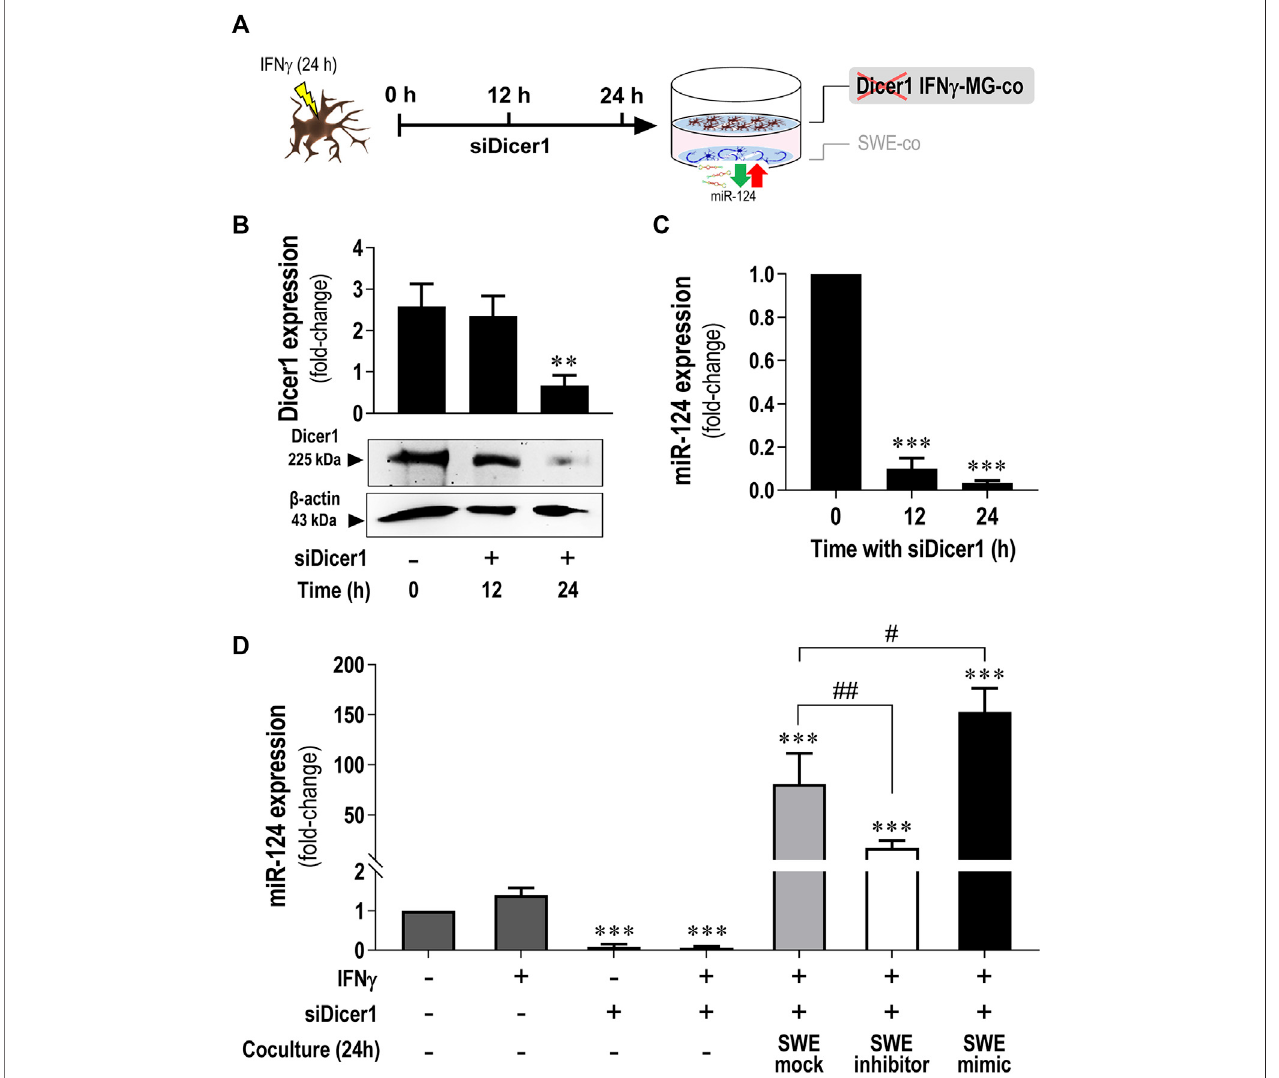
FIGURE7| IncreasedmiR-124 expression levelsarepresentinDicer1-silenced IFN γ -MGupon established cocultureswiththeSWEcellsmodulatedformiR-124. After differentiation, SWE cells were transfected with mock, inhibitor, and mimic of miR-124, while CHME3 microglia were pre-treated with IFN γ (IFN γ -MG) before transfection with Dicer1 siRNAs, as detailed in Materials and Methods . (A) Schematic representation of siRNA-mediated Dicer1 silencing in IFN γ -MG cells, followed by coculture with miR-124 modulated SWE cells. (B) Representative western blot images and relative densitometric quanti fi cation of Dicer1 expression in IFN γ -MG after 0 (naïve), 12, and 24 h ofDicer1 siRNA incubation. (C) miR-124 expression levels in IFN γ -MG after 0 (naïve), 12, and 24 h of Dicer1 siRNA incubation. (D) miR-124 expression levels in IFN γ -MG in monocultures upon the indicated conditions or in coculture with SWE cells modulated for miR-124 after 24 h incubation. Results are mean±SDfromatleastthreeindependentexperiments.** p < 0.01and*** p < 0.001 vs .naïveMG;## p < 0.01 vs .IFN γ -MGcoculturedwithSWEmock,one-wayANOVA with the Bonferroni post hoc test. SWE, human SH-SY5Y cells expressing the APP695 Swedish mutant protein; MG, CHME3 human microglial cells; IFN γ -MG, IFN γ - stimulated CHME3 human microglia cells; co, coculture; siDicer1, siRNA-mediated Dicer-1 silencing.